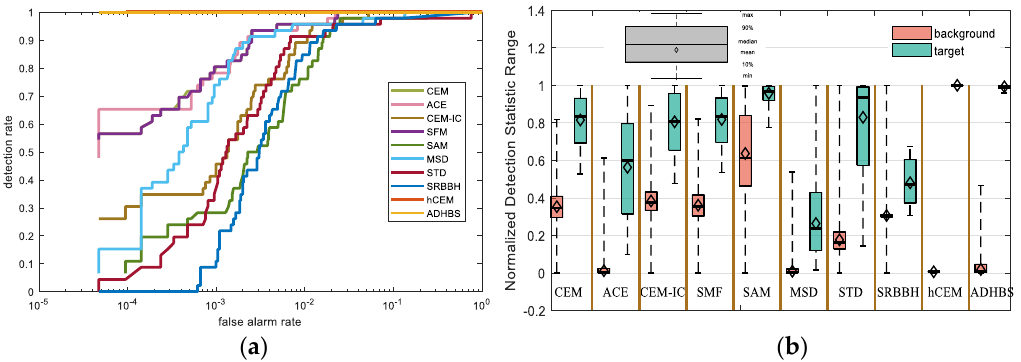
Figure 13. ( a ) The ROC curve comparison for the Indian Pines data. ( b ) The separability map for the Indian Pines data.